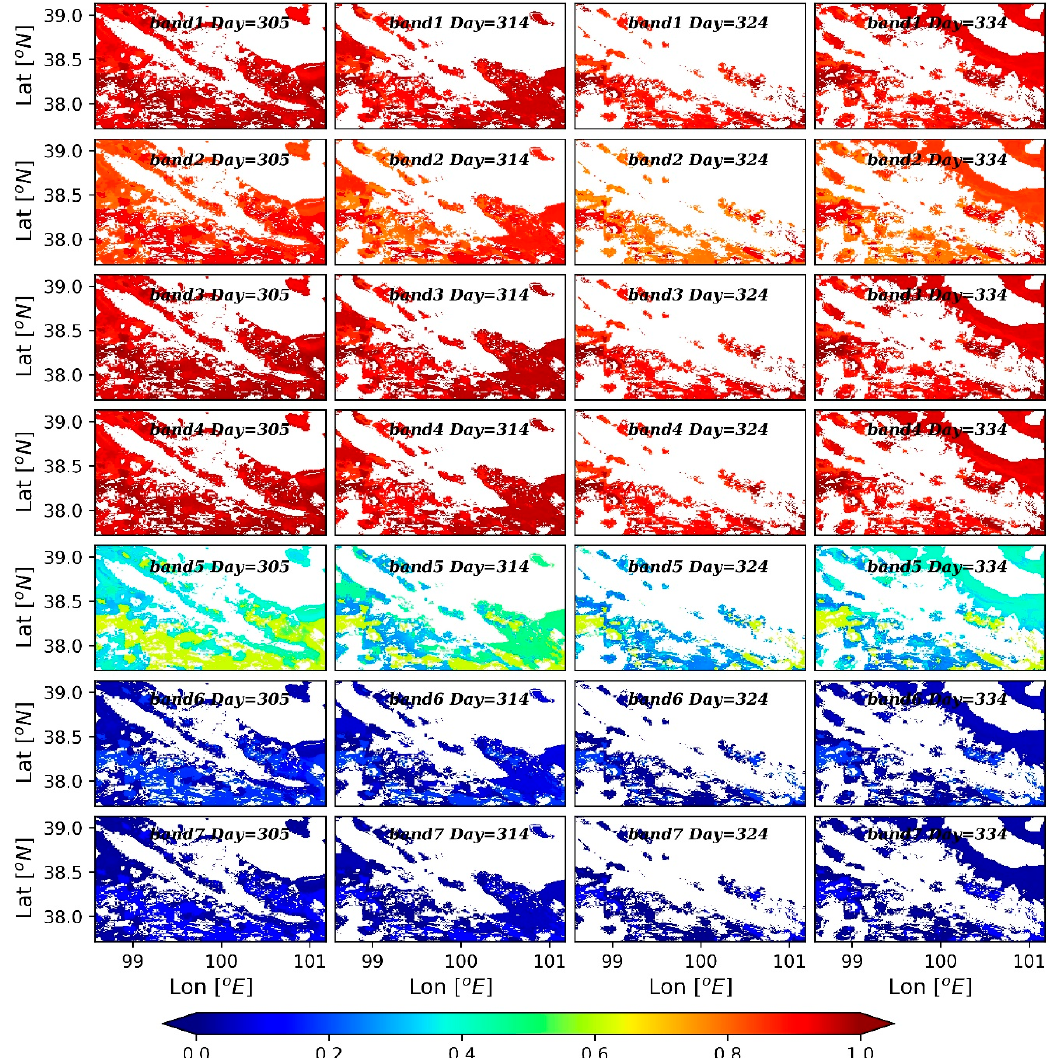
Figure 9. Predicting the narrowband snow albedo targeting MOD09GA reflectance data based on the integrated model (seven reflectance band ranges are simulated for the MOD09GA reflectance data, and Julian days 305, 314, 324 and 334 in 2014 are taken as examples: the row direction is the Julian day, and the column direction is the band order). The integrated model simulation results and remote sensing observation results are compared at the same time.